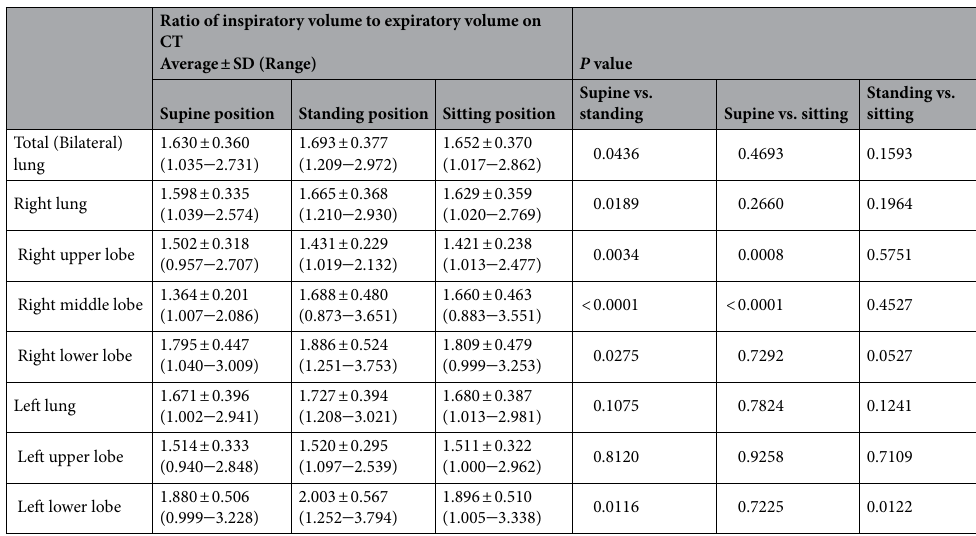
Table 5. Ratio of inspiratory lung/lobe volume to expiratory lung/lobe volume as determined using CT in the supine, standing, and sitting positions (100 volunteers). P < 0.0167 was considered to be statistically significant, with Bonferroni correction for multiple